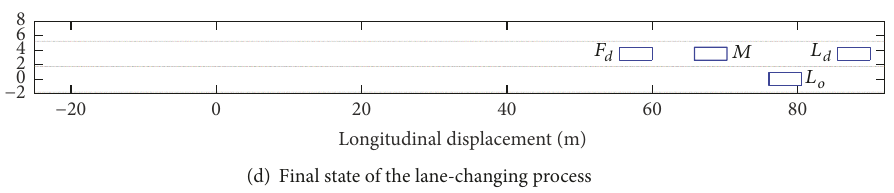
Figure 8: Optimal trajectory simulation of 𝐹 𝑑 with uniform coordination.